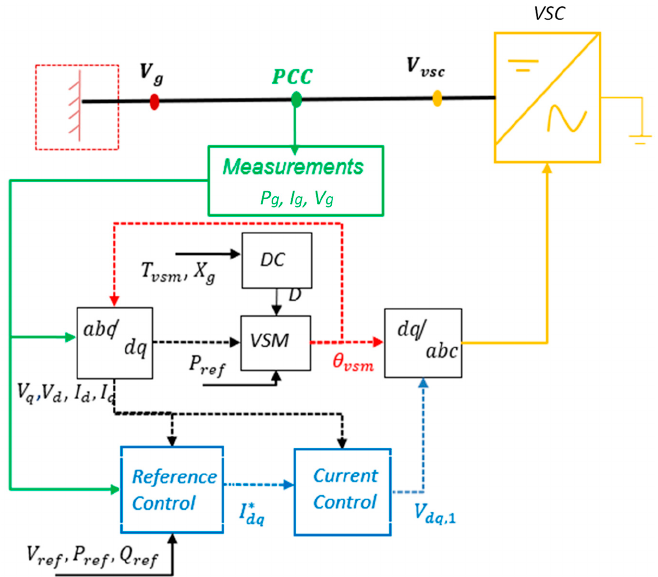
Figure 2. Block diagram of the VSM model and the main control loops.